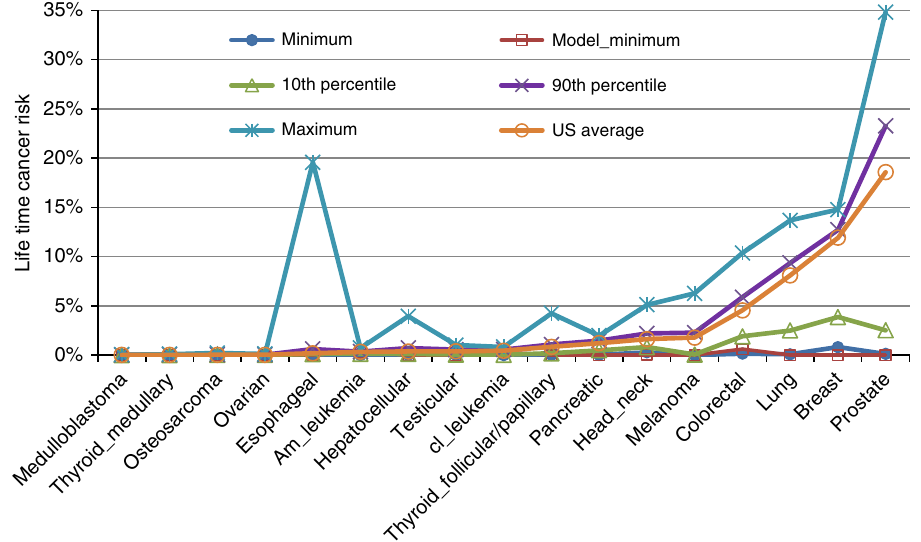
Fig. 3 Shown are the (conservative non-zero) minimum, the 10th and 90th percentiles, the US average, and the maximum of the lifetime cancer risk based on World cancer registry, and the stem-cell-model based minimum 6 . The huge disparity between the US average and world minimum indicates that cancer is unlikely the end result of a universal endogenous carcinogenesis mechanism unaffected by exogenous factors (published with permission 6